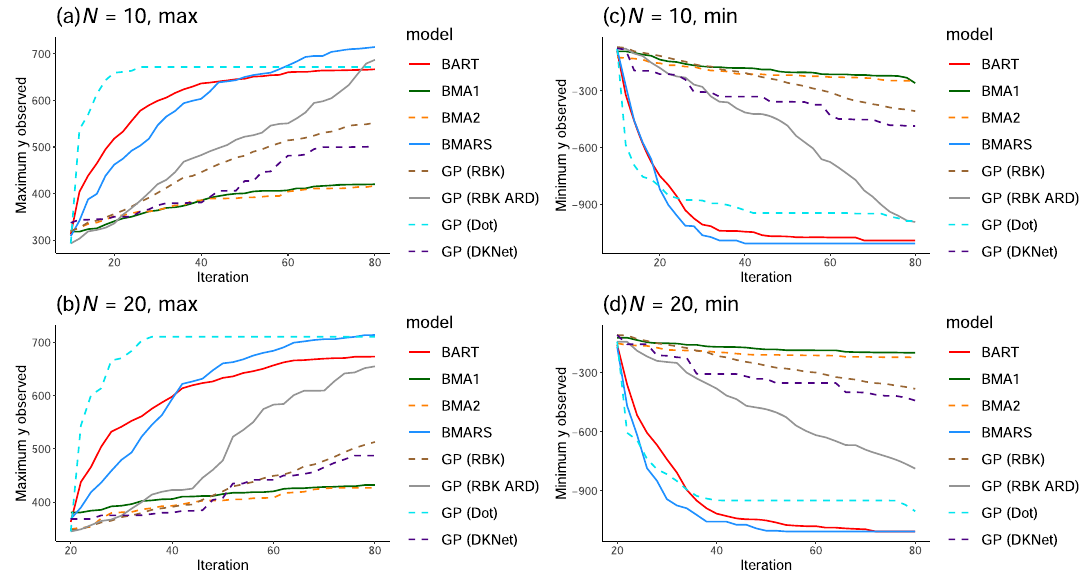
Fig. 3 The average maximum or minimum stacking fault energy (SFE) [mJ ⋅ m − 2 ] observed on each model in each iteration. a The maximum SFE with the initial set of sample size N = 10. b The maximum SFE with the initial set of sample size N = 20. c The minimum SFE with the initial set of sample size N = 10. d The minimum SFE with the initial set of sample size N = 20.